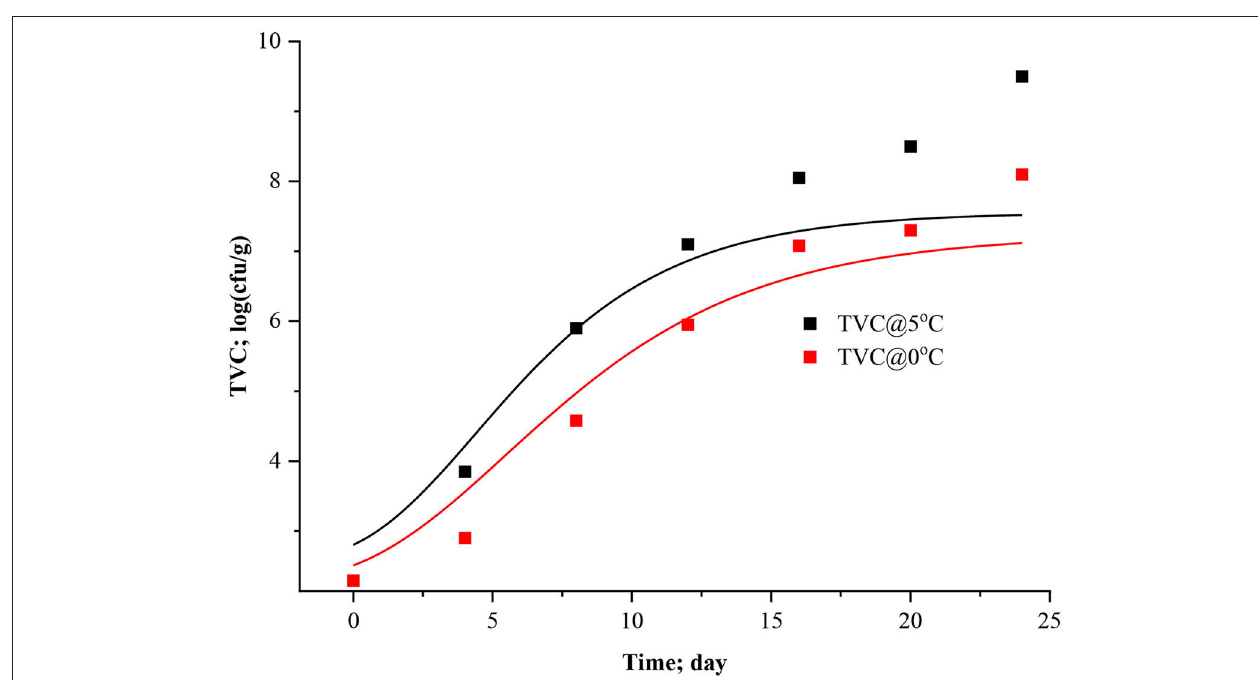
FIGURE 8 | Modified Gomperts model curve for TVC of Rohu fish stored.